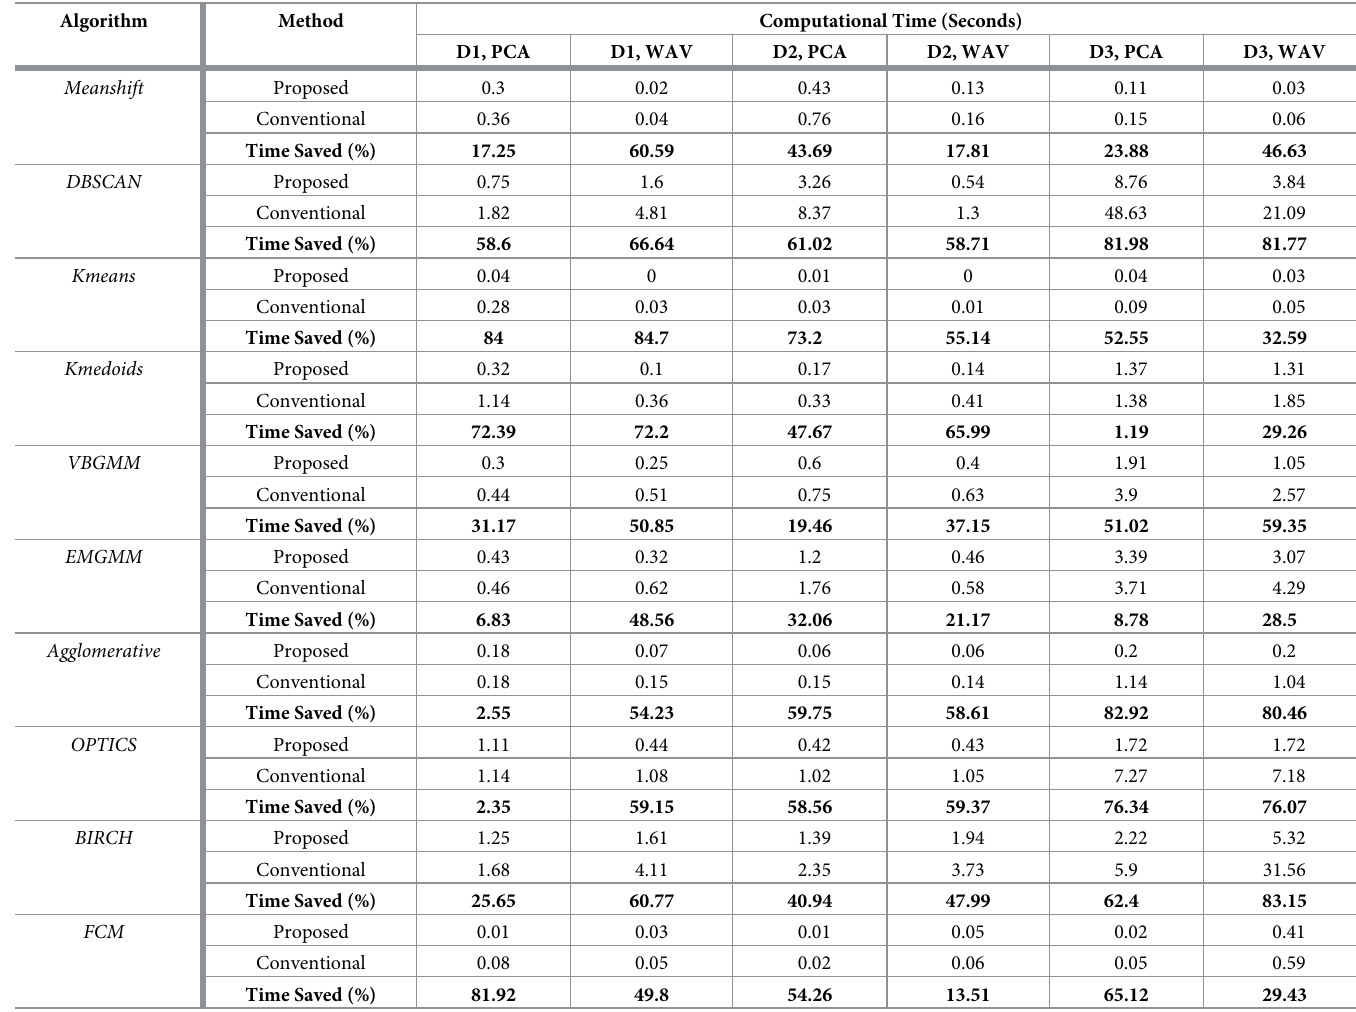
Table 2. Computational times and time based performance improvement for ten clustering algorithms. Algorithm